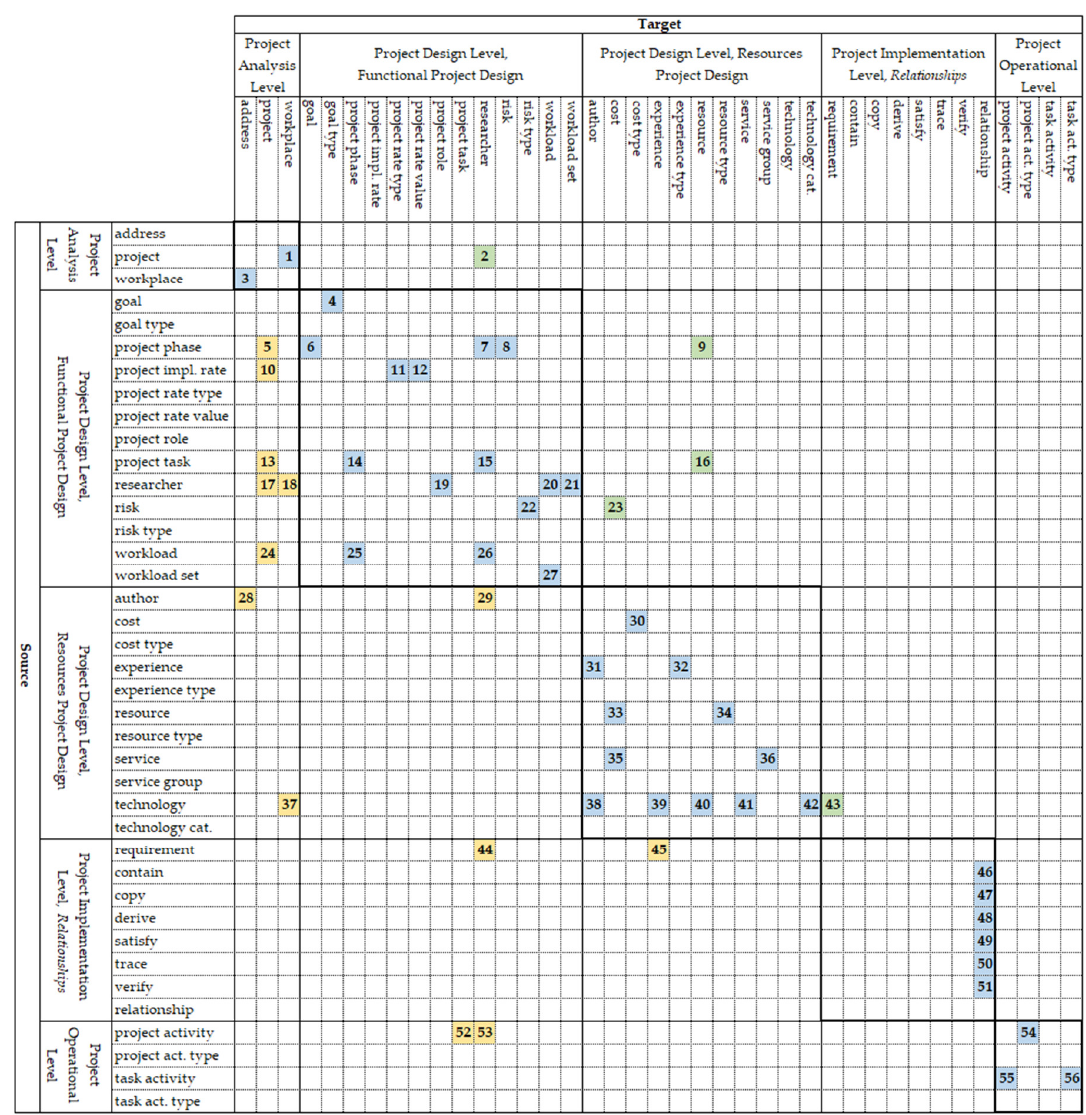
Figure 16. ResearchML 3.09 abstraction layers and objects.